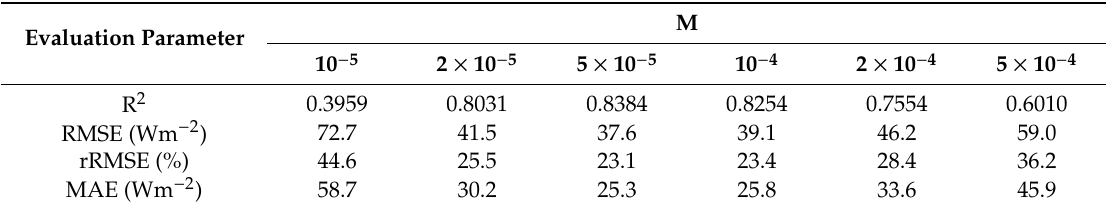
Table 1. Evaluation parameters computed by di ff erent values of µ .